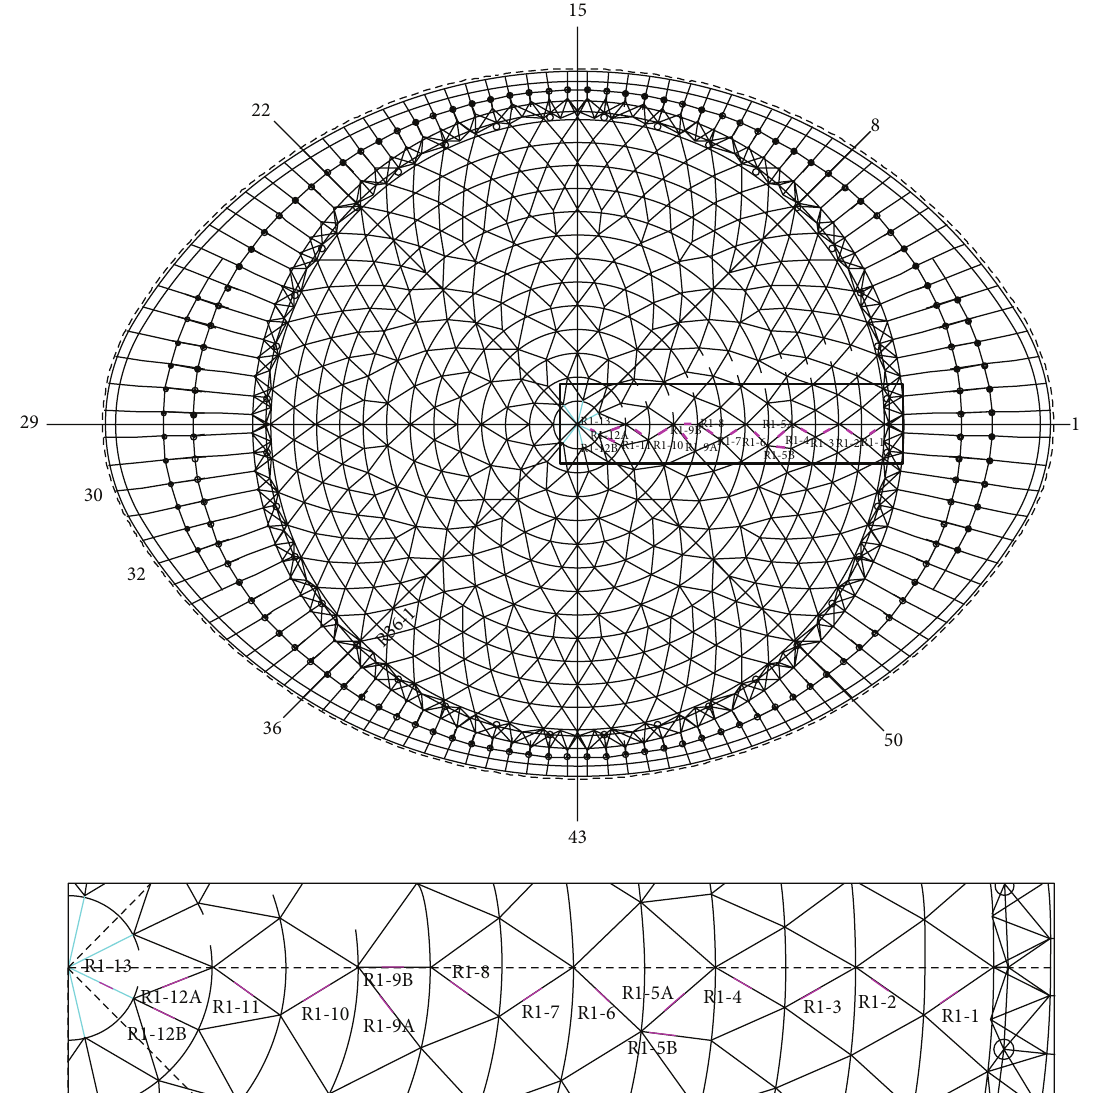
Figure 7: Layout of radial